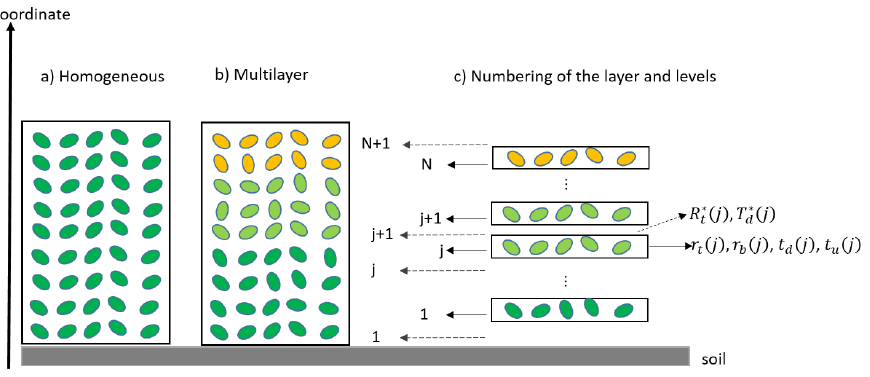
Figure 2. Homogeneous ( a ) and multi-layer canopies with vertical heterogeneity of leaf optical properties and orientations ( b ). Numbering the layers (solid arrows) and flux levels (dashed arrows) for applying the four-stream theory to multi-layer canopies ( c